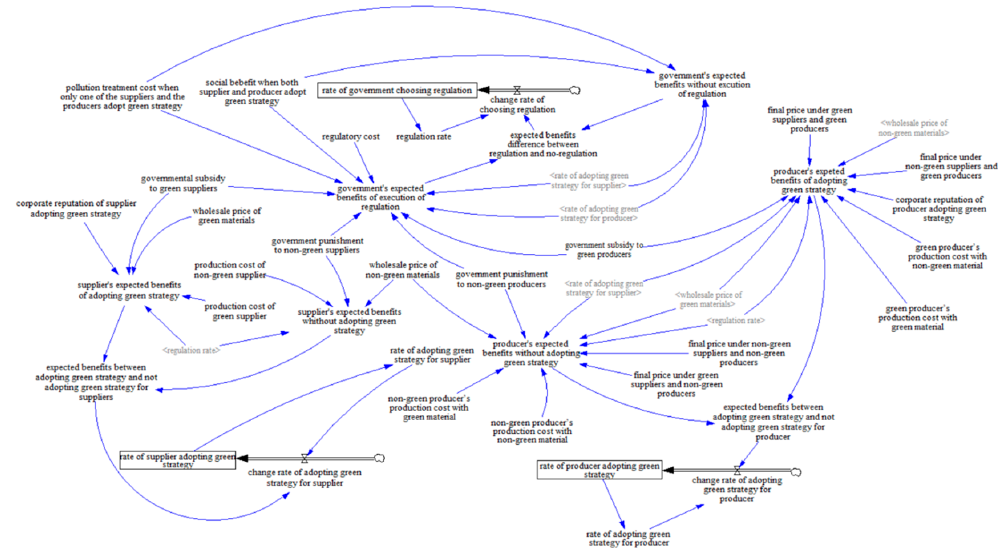
Figure 4. SD model of evolutionary game among suppliers, manufacturers and governments.